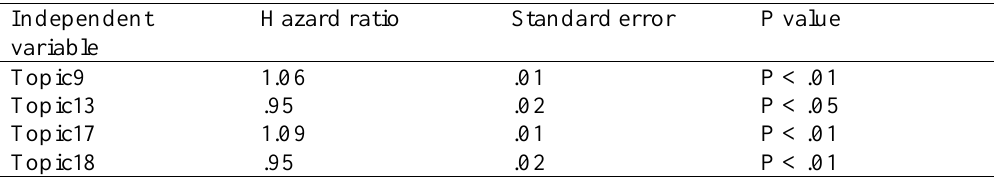
Hazard Ratios for Four Different Subcommunity Topics in the Python Course Independent variable